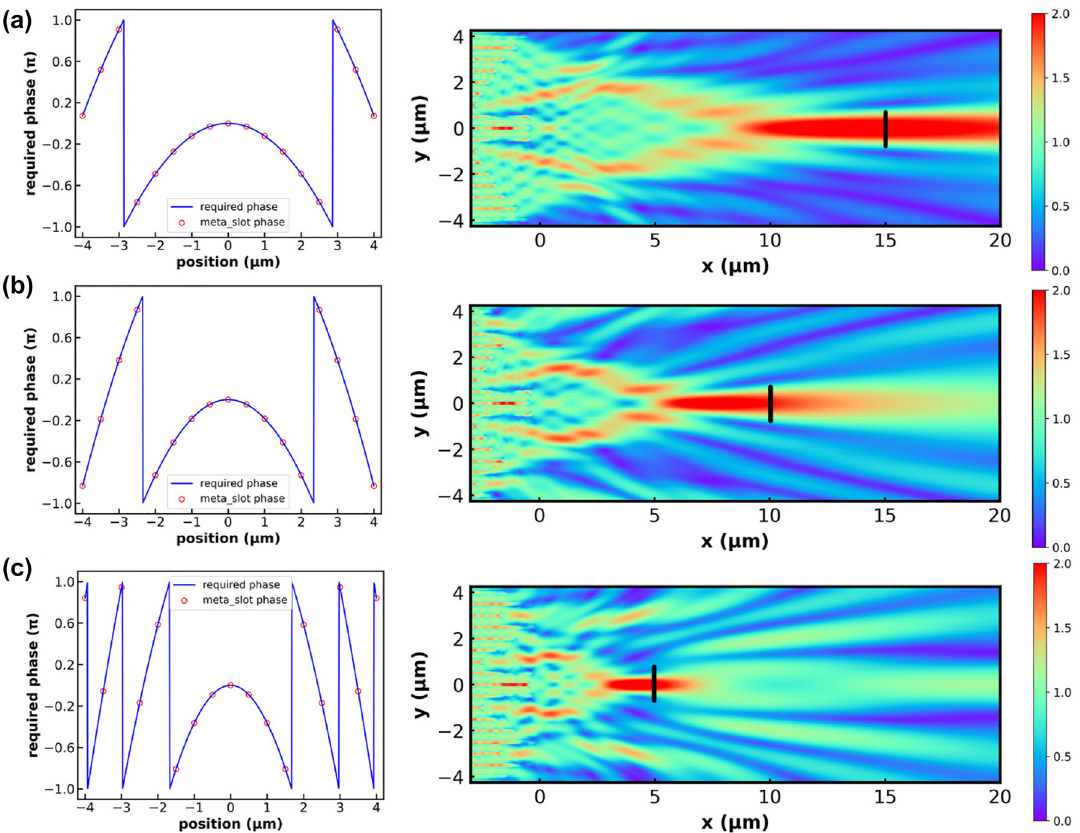
Figure 3: Phase distribution and electric field intensity of the on-chip meta-lenses with focal length of 15 μ m (a), 10 μ m (b) and 5 μ m (c) respectively. The blue line is the ideal phase distribution along y direction, where the red hollow circles indicate the chosen phase at the exact slot position. The black lines at the focal point in the field distribution plot indicate the cutting plane to calculate the focusing efficiency. The focus efficiency is 0.317, 0.402 and 0.577 for the focal length of 5 μ m, 10 μ m and 15 μ m,